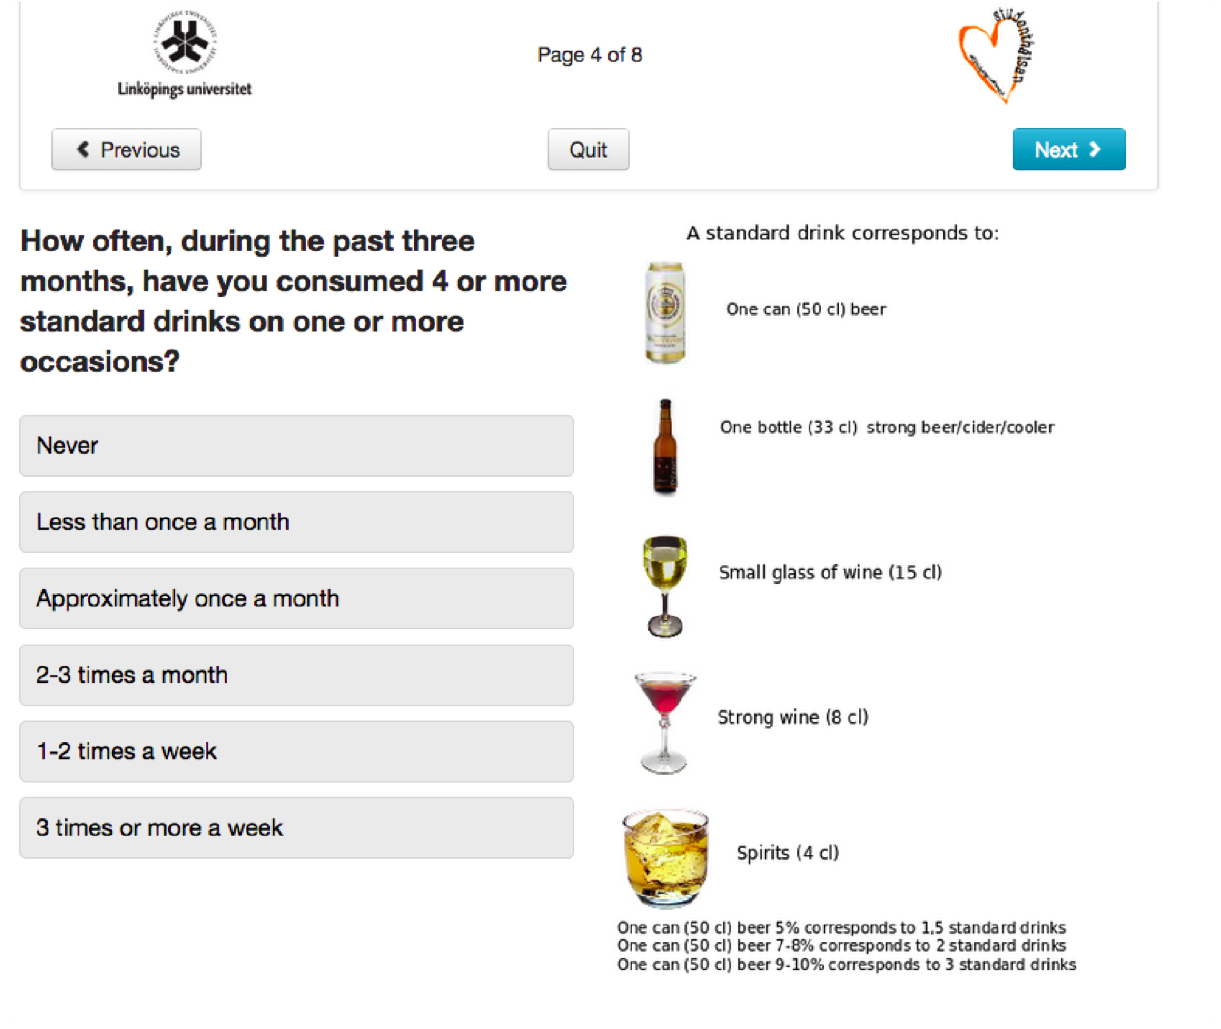
Figure 1. Screenshot of AMADEUS: assessment of heavy episodic